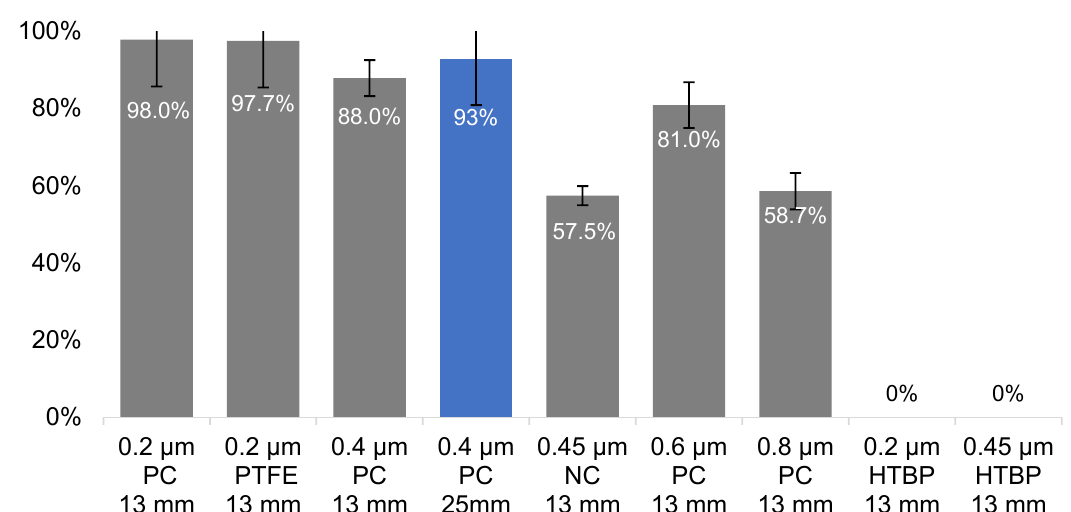
Figure 1. Capture efficiency of C. jejuni cells with various filter types. Pore sizes: 0.2–0.8 µm; filter types: PC—hydrophilic polycarbonate filter, PTFE—hydrophobic polytetrafluoroethylene, NC—nitrocellulose, HTBP—hydrophilic polycarbonate filter-brown; filter diameters—13- or 25-mm. Blue bar—filter type selected for further experimentation.